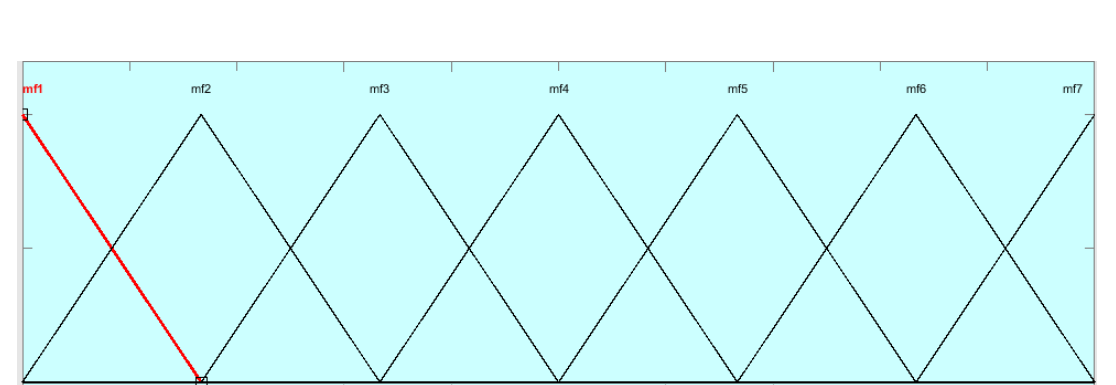
Figure 1. Membership function of output variable.